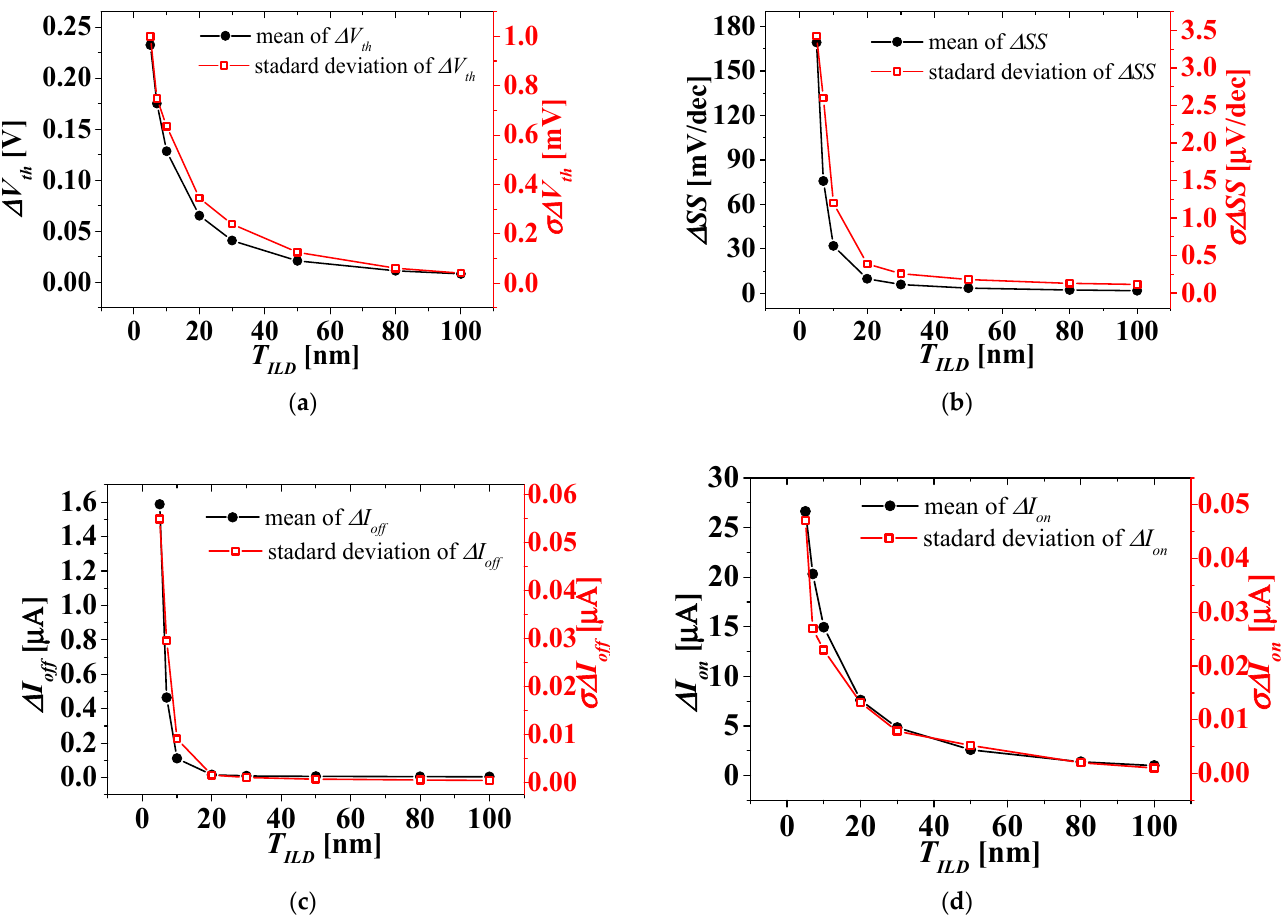
ard deviations of the electrical parameter changes of Δ V th , Δ SS , Δ I off , and Δ I on , respectively. The black-filled and red, empty squares denote the means and standard deviations of electrical parameter changes by V BG between 0 and 1 V, respectively. In Figures 8–10, the means and standard deviations of all electrical parameters increase as T ILD decreases, and especially when T ILD is over about 30 nm, all the electrical parameter changes are almost constant and relatively very small, and thus the electrical coupling [23,30] and its distri- bution can be ignored. Although the means of the electrical parameter changes are almost the same in all the three case, their standard deviations for the WFV of both the top- and bottom-tier MOSFET gates considered were greater than those for the other two cases.